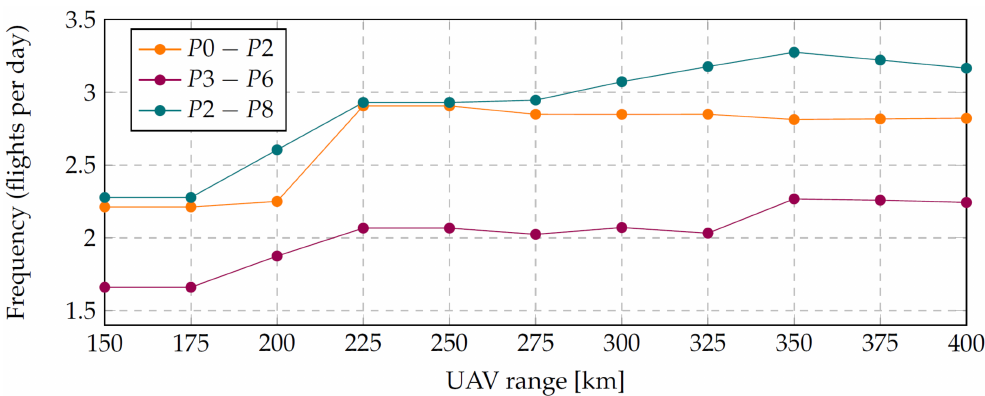
Figure 8. Dependence of the monitoring frequency on the UAV